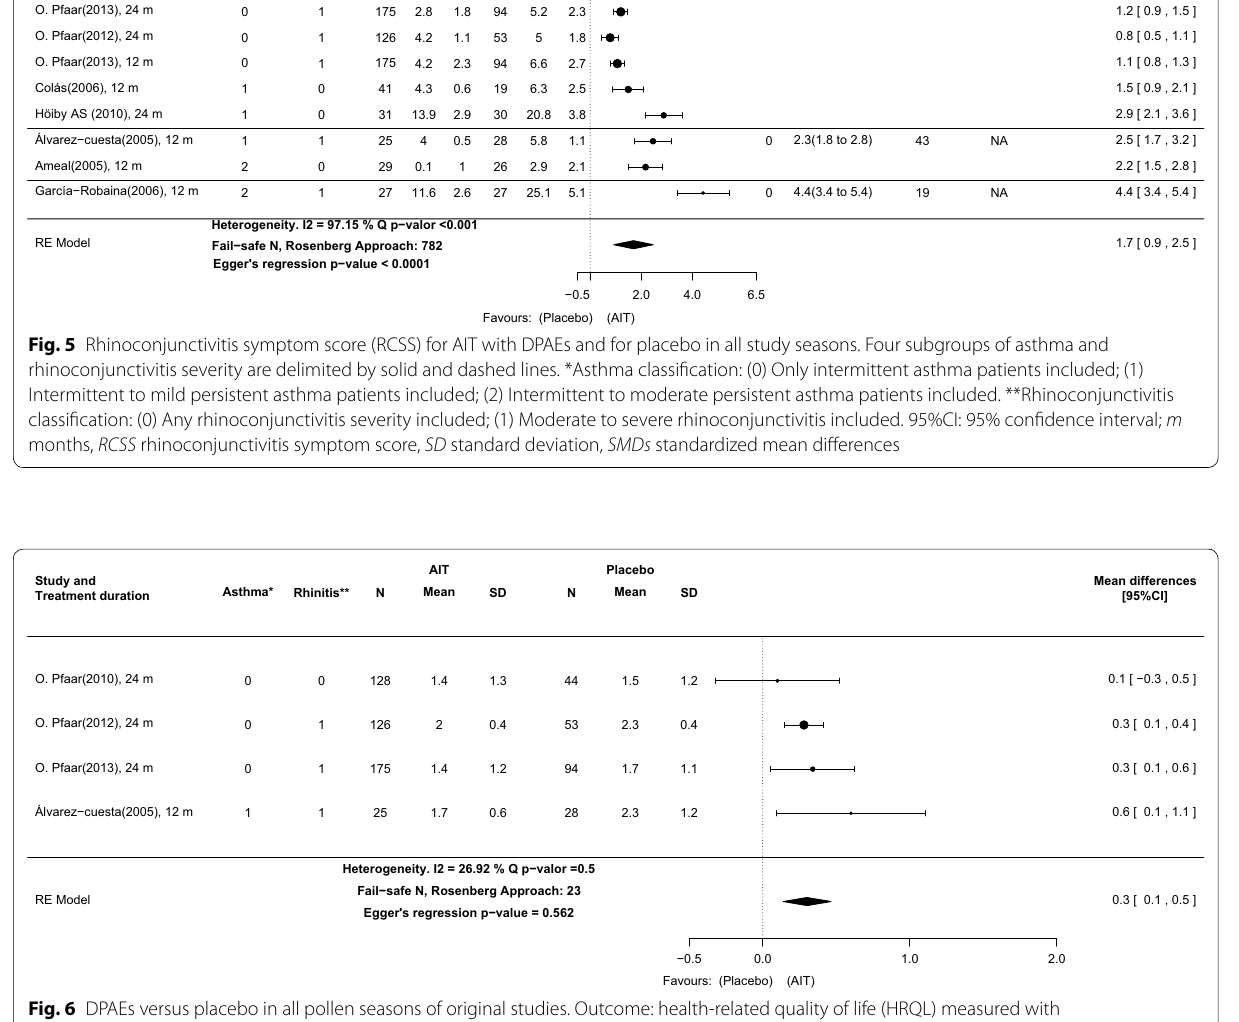
proportionally to the severity of asthma and rhinocon- junctivitis in the patients included (Fig. 4). cSMS evaluated in all study seasons (10 measures from 8 publications) Considering the measures of all study seasons, the results are in accordance with pre- vious analyses. The cSMS standardized mean differ- ences between AIT with DPAEs and placebo in the four